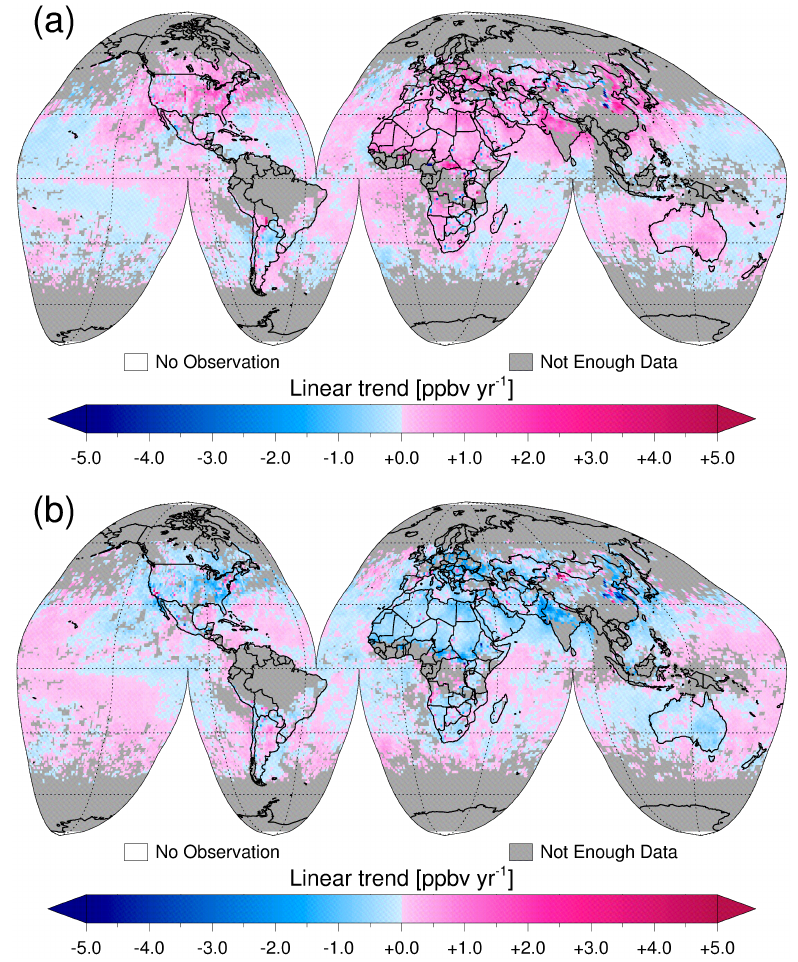
Fig. 5. The linear trends of retrieved states under the assumption that the true state is (a) − 50% or (b) + 50% higher than the a priori state (i.e., x = x 0 ± 50% × x 0 ). The trends of retrieved states range from -10.71 to +13.21 ppbv yr -1 (-5.68 to +8.84 % yr -1 ).